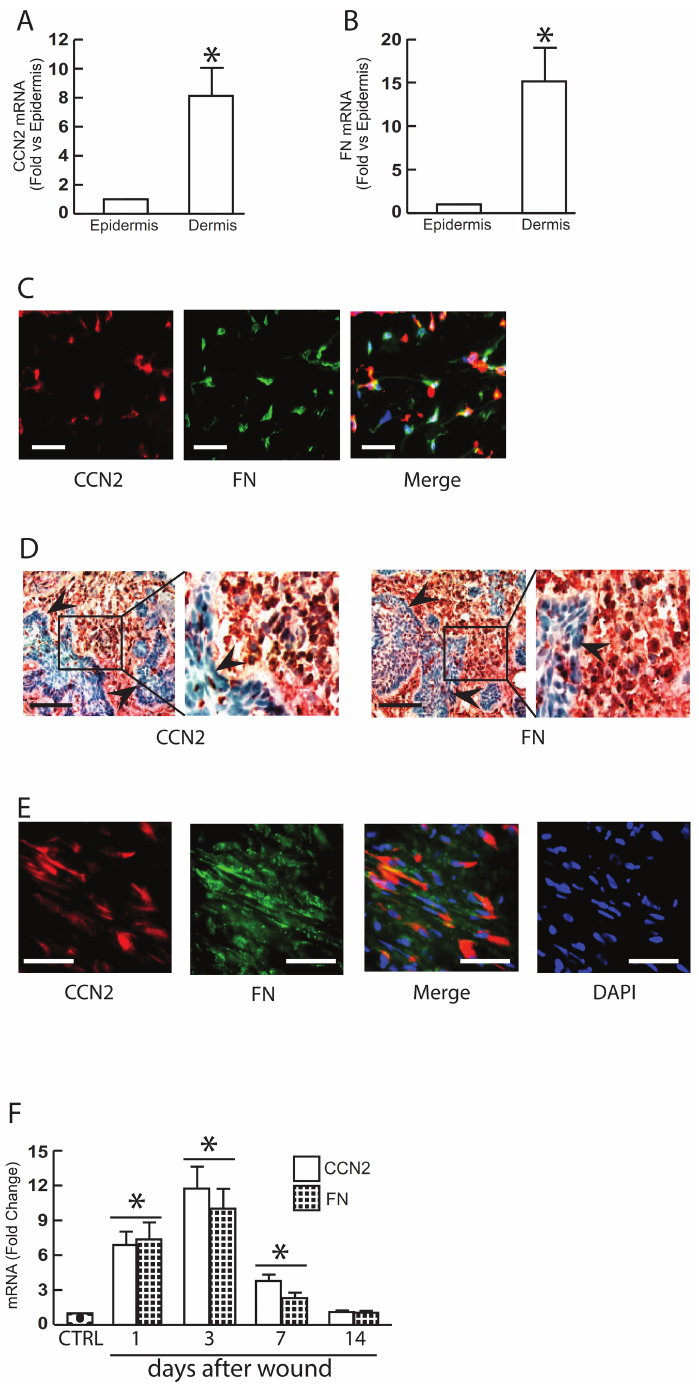
Fig 5. CCN2 and FN are primarily expressedin the dermis of normal human skin, stromal tissues of skin SCC, and wounded human skin. (A, B) Epidermisand dermis were capturedby LCM. Total RNA was extracted from captured tissue, and mRNA levels were quantifiedby real-time RT-PCR. CCN2 (A) and FN (B) mRNA levels were normalized to the housekeeping gene 36B4, as an internalcontrol for quantification. Data are relative levels to 36B4 (mean ± SEM), N = 6, * p < 0.05.(C) Doubleimmunostaining for CCN2 and FN in normalhuman skin. OCT-embedded normalhuman skin sections (7 μ m) were co-immunofluorescence stainedwith CCN2 and FN. Representative of six individuals.Bar = 50 μ m.(D) Expression of CCN2 and FN in the stromal tissues of SCC was determinedby immunohistology. Arrow heads indicatetumor